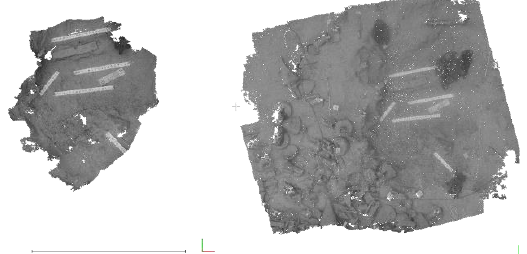
Figure 2: The Reference Point Cloud (Left) and The Photoscan tested point cloud from the higher